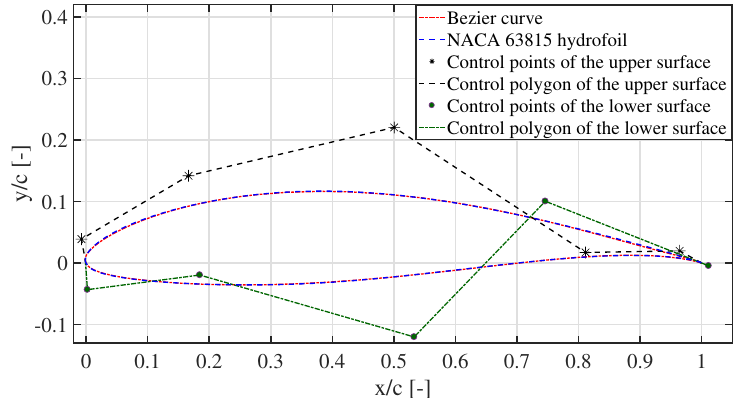
Figure 2. Original and Bezier curve parameterized NACA 63815 hydrofoil, where X/C and Y/C are the normalized distance in x and y directions to the hydrofoil chord length